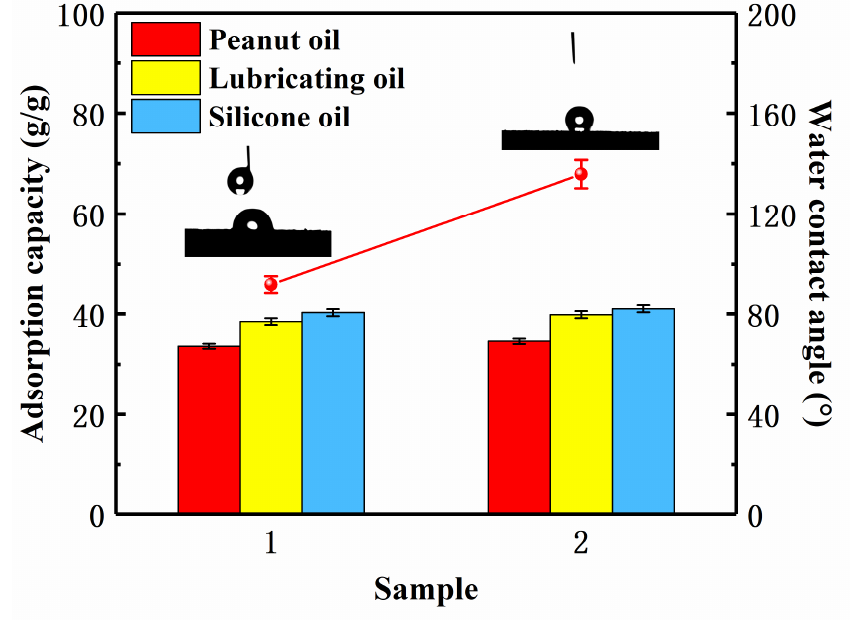
Figure 8. The adsorption capacities and water contact angles of composite sponges sample 1 and sample 2.